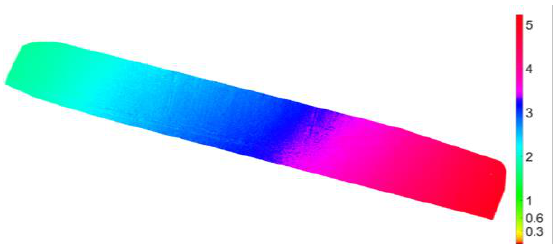
Figure 18. The cloud 3D distance maps before the ICP registration, between Blocks 3 and 4 in the overlapping area, expressed in meters